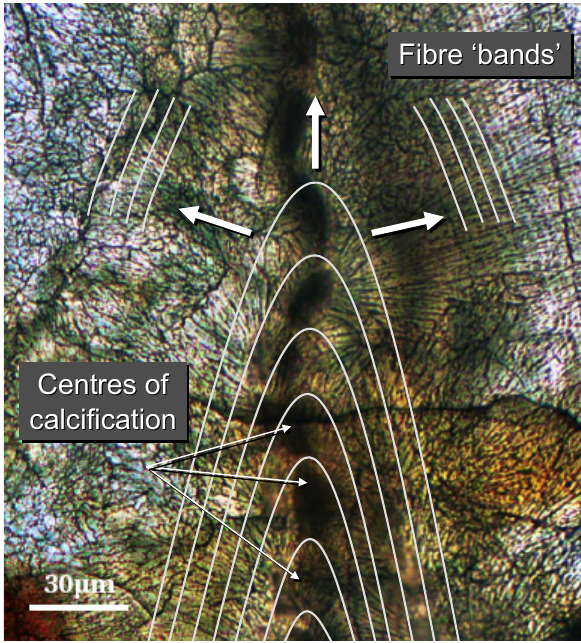
Fig. 4. Petrographic thin section of a Porites skeleton in the ver- tical extending region of a skeletal spine. The “centres of calci- fication” (COC) appears as a vertical line of discrete dark blobs. Their length ( ∼ 30µm) confirms that they are daily accretions. Bundles of needle-shaped fibres are seen to radiate out from each COC. The needle-shaped fibres consist of composite “daily” growth bands ( ∼ 2 to 5µm). (Image courtesy of Anne Cohen, Woods Hole Oceanographic Institution.)